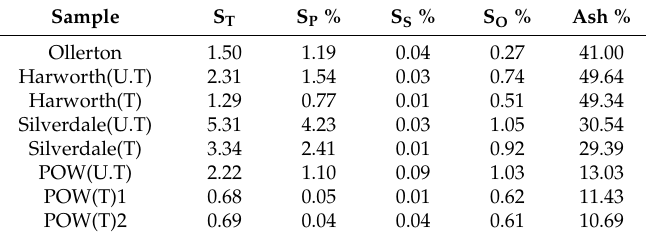
Table 3. Sulphur analysis of the samples for TPR study.